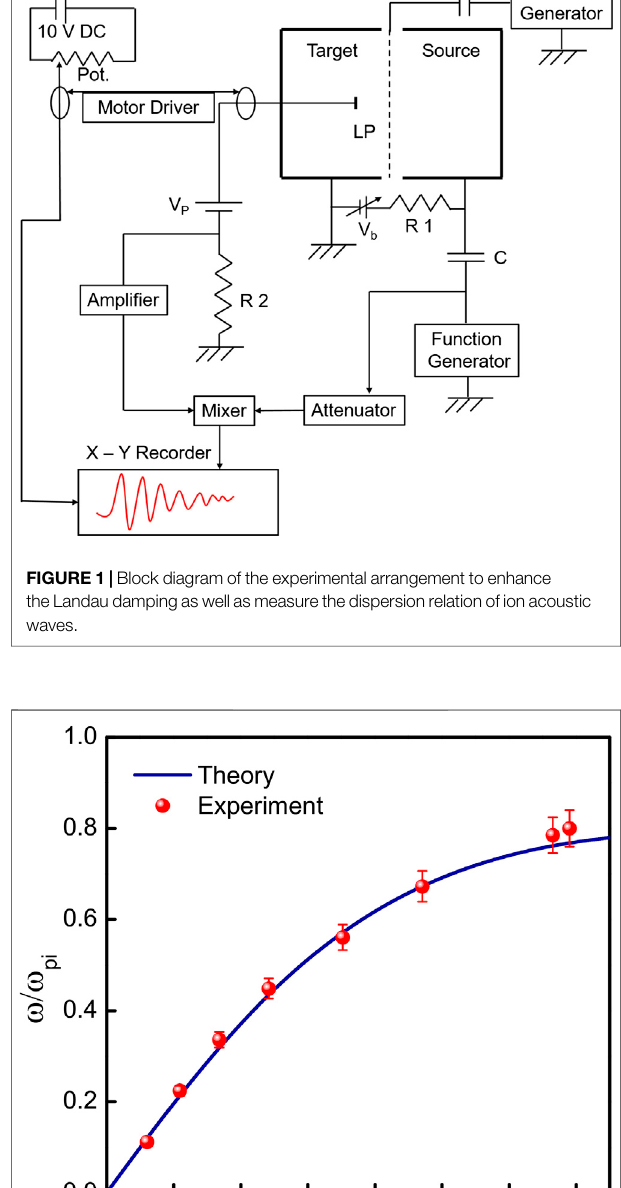
an rf signal of frequency f HF (cid:2) 900 kHz is applied to the separation grid to heat the ions from a function generator. The desired Landau damping rate is obtained by varying the peak to peak voltage ( V HF ) in the range 0 – 100 mV. In Figure 1 , the schematic of the experimental arrangement to control the Landau damping strength is presented.